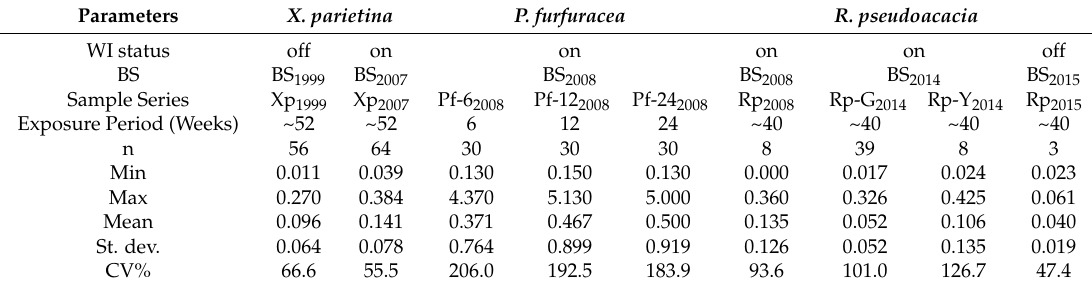
Table 2. Basic descriptive statistics of Hg content measured in the nine series of biomonitor samples collected between 1999 and 2015. Exposure period for the epiphytic lichen Xanthoria parietina and the leaves of Robinia pseudoacacia were estimated according to the works of [24,25]; those of the transplanted lichen Pseudevernia furfuracea were taken from the work of [19]. WI: waste incinerator; on: WI active; off: WI inactive; BS: biomonitoring survey; n: number of exposed or collected samples; Min, Max, Mean: minimum, maximum and mean Hg concentration value; St. dev.: standard deviation; CV%: percent variation coefficient.